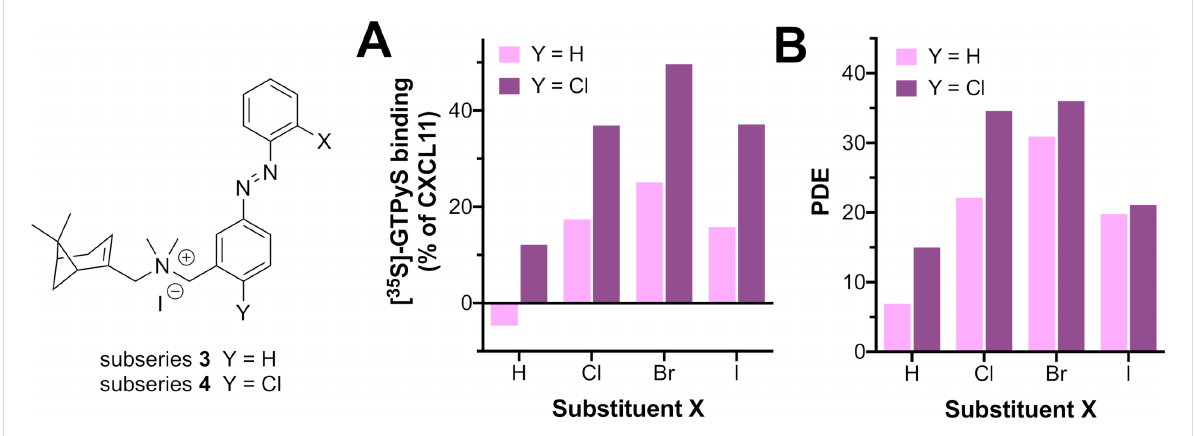
Figure 3: Comparison of compounds belonging to the subseries 3 or 4 with a halogen substitution on the ortho -position of the outer ring (X). (A) Activ- ities of cis -isomers at 10 µM on CXCR3-mediated G protein activation. (B) PDE values at 10 µM.